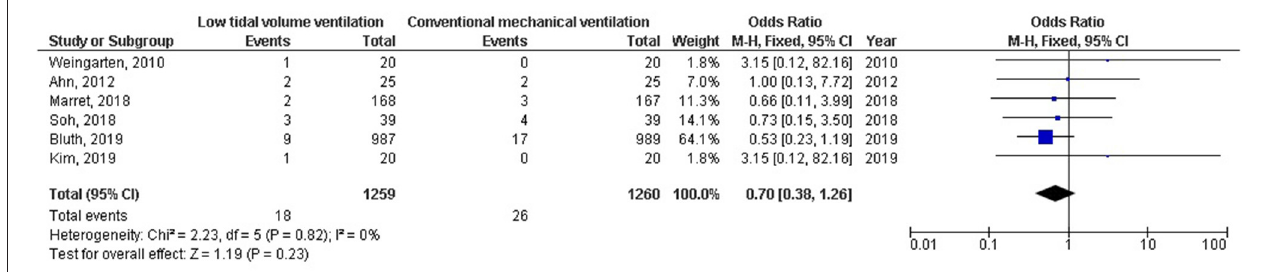
FIGURE 10 | Forest plot of the low tidal volumes strategy vs. conventional mechanical ventilation in subjects undergoing surgery on pulmonary edema.